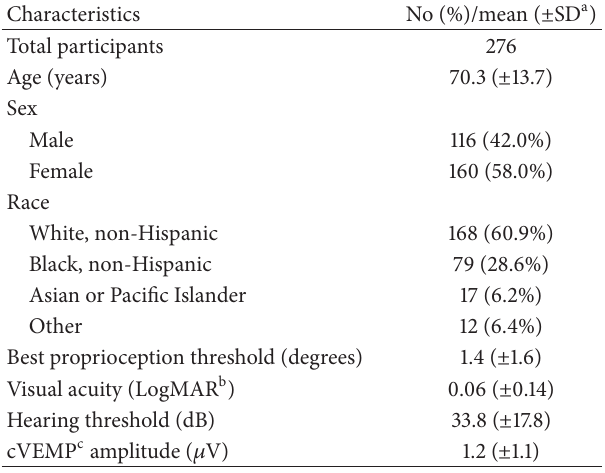
Table 1: Demographic characteristics and baseline sensory func- tion, Baltimore Longitudinal Study of Aging